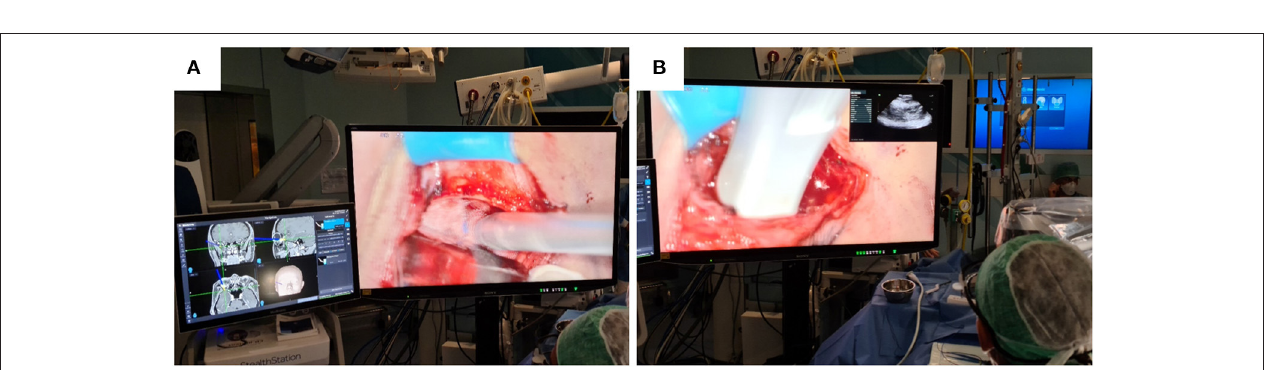
FIGURE 1 | Preoperative enhanced MRI of the orbits (left, axial; right, coronal) showing the cavernous hemangioma located in the inferior lateral part of the right orbital intraconic space (A) and detail of tumor localization using navigation (B) . Postoperative MRI showing complete removal of the hemangioma (C) . The transpalpebral approach allows a minimally invasive access to the retro-orbital space ensuring excellent esthetic and functional results (D) .